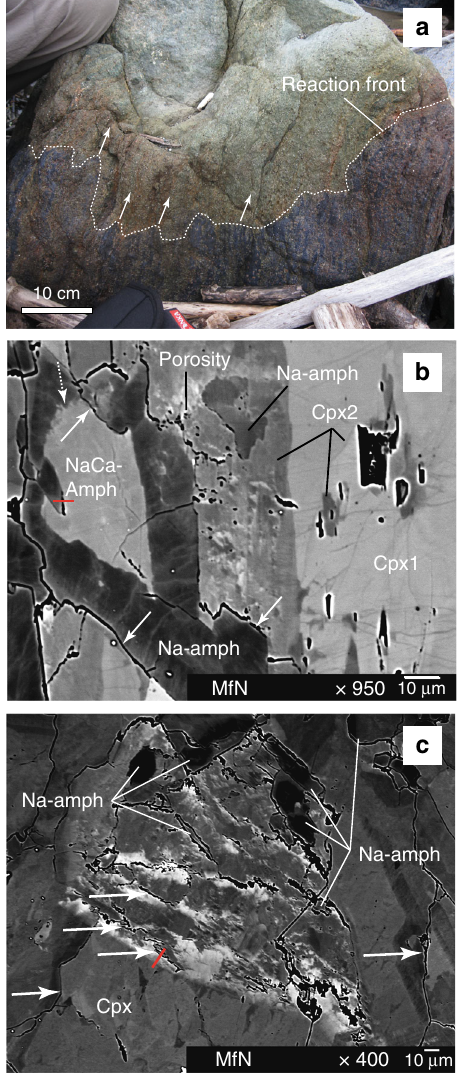
Fig. 1 Meso- and micro-scale textures resulting from fl uid in fi ltration into the sampled rock. a A sharp reaction front in the meter-sized block marks the extent of fl uid in fi ltration (bluish areas) into the dry eclogite (greenish areas). b Back scattered electron (BSE) image of a fl uid-induced reaction zone. Initial fl uid in fl ux in porous areas modi fi es the clinopyroxene (Cpx) composition (patchy areas). Subsequent formation of sodic amphibole (Na- amph) from sodic-calcic amphibole (NaCa-amph) and cpx is associated with up to 1 µ m wide reaction zones (solid arrows). c BSE image of the fl uid- induced reaction zones in cpx showing the patchy zoning (white cloudy areas) and the associated interconnected pore space together with the formation of sodic amphibole. The red lines mark the positions of the FIB sections from Figs. 2 and 3 taken across the reaction